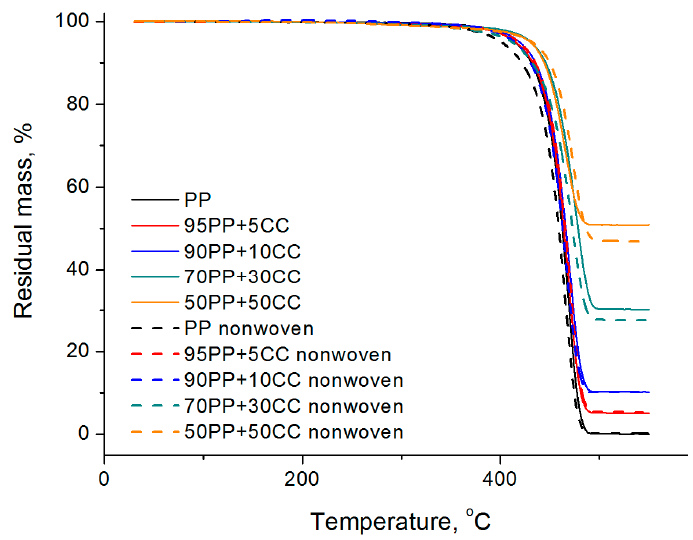
Figure 7. TGA curves of the composites (solid lines) and nonwoven materials (dash lines).